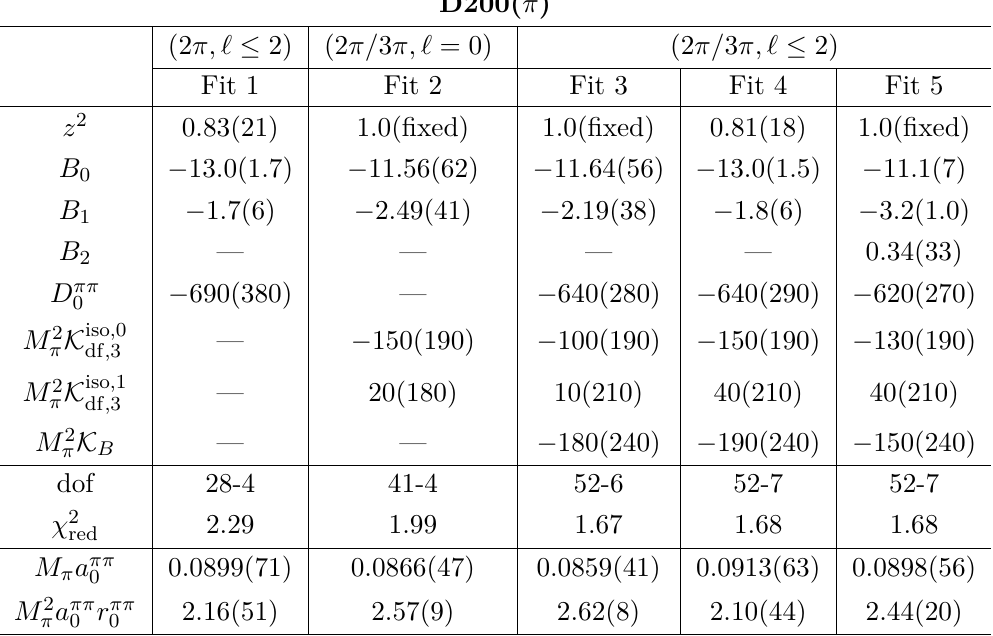
Table 6. Fit results for pions on the D200 ensemble using M π L = 4 . 199492 , with notation as in table 4. Each fit contains all 2 π + energy levels (in the appropriate irreps) below E ∗ and most 3 π + levels (in the appropriate irreps) below E ∗ high-energy 3 π + levels with unusually large errors, only including the lowest two d 2 = 6 levels and lowest three d 2 = 8 levels in the A 2